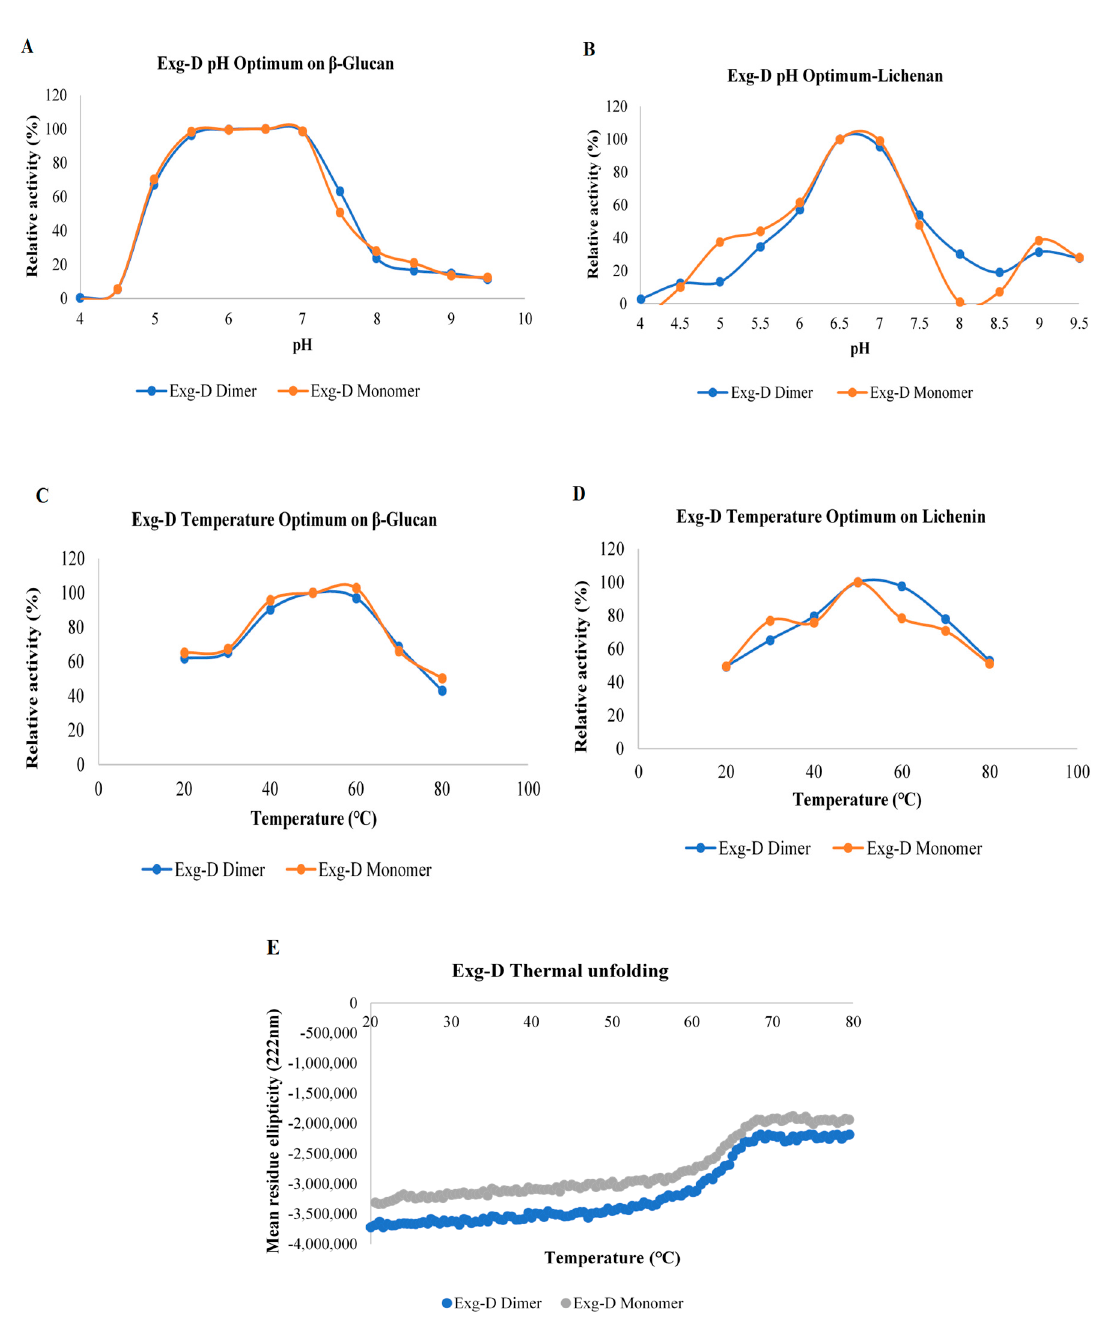
Figure 2. The pH optima of the dimeric and monomeric forms of Exg-D during the hydrolysis of β -glucan ( A ) and lichenin ( B ). The temperature optima of the dimeric and monomeric forms of Exg-D during the hydrolysis of β -glucan ( C ) and lichenin ( D ). The thermal unfolding of the monomeric and dimeric forms of Exg-D ( E ). The experiments were performed in triplicate and error bars represents standard deviations. Experiments were performed in triplicate and the values represent means ± SD.